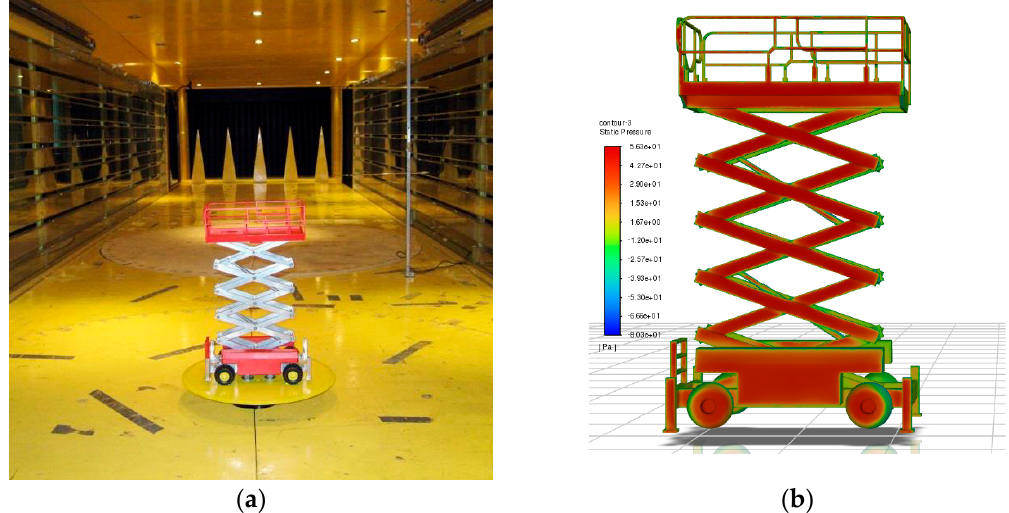
Figure 5. Model of the scissor lift at medium working height (conf. 3): ( a ) During the aerodynamic tests, ( b ) the CFD simulation.